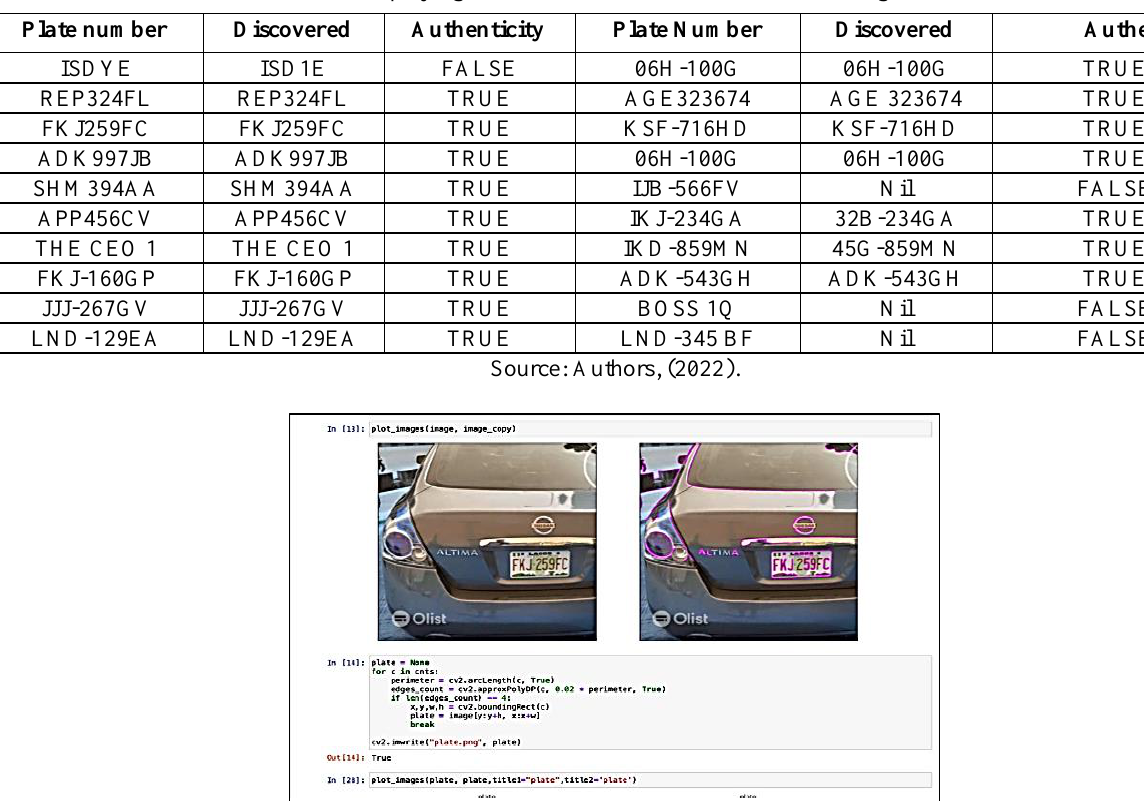
Table 1: Displaying Results of Success and Failures of our algorithm.